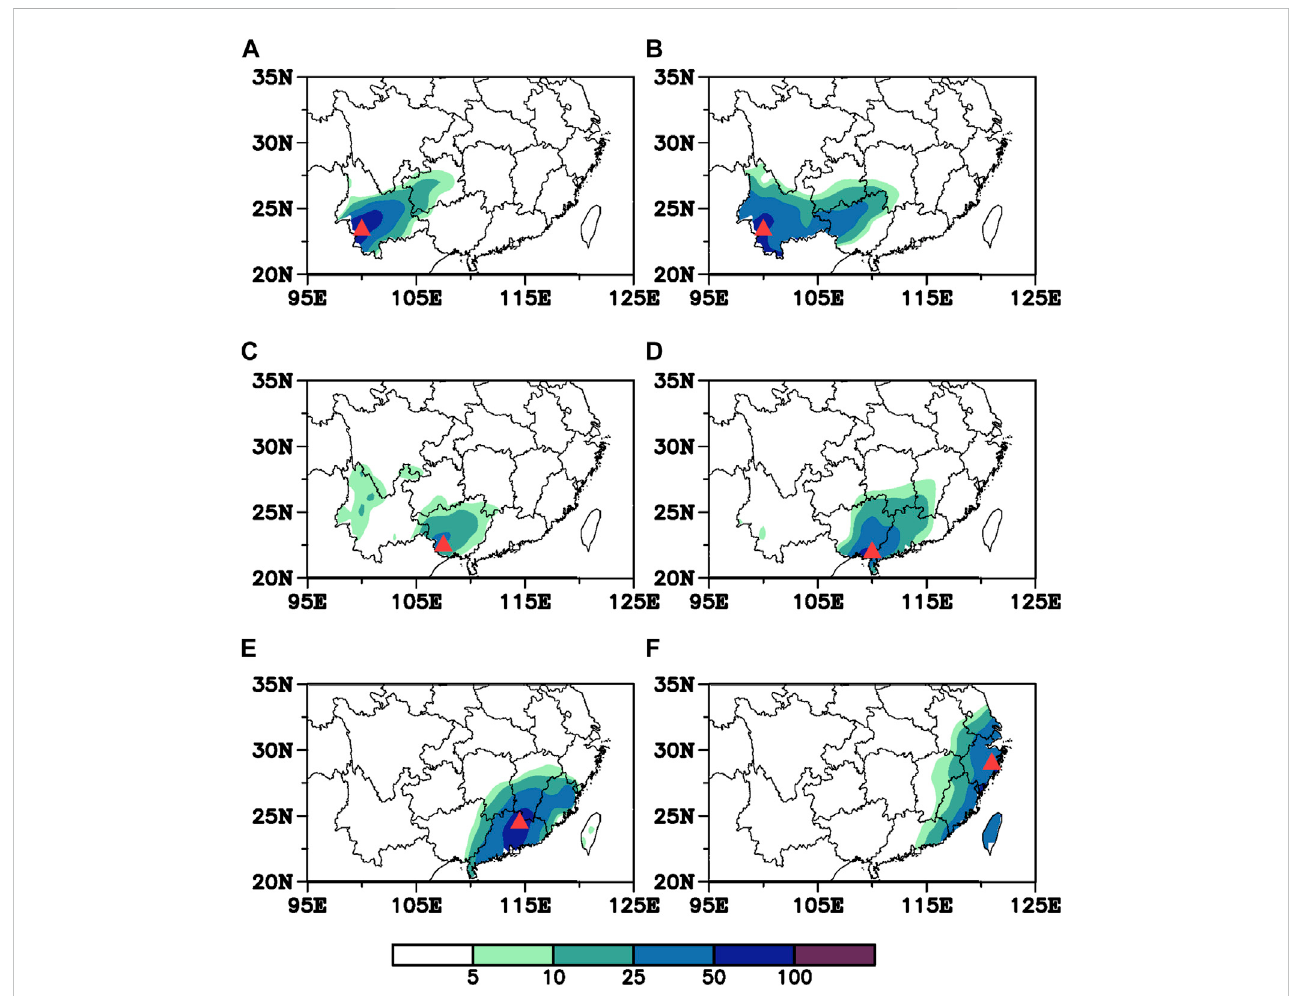
FIGURE 3 Distribution of the daily precipitation on January (A) 8, (B) 9, (C) 10, (D) 11, (E) 12 and (F) 13 in 2015 (units: mm). The red triangle indicates the large-value center of